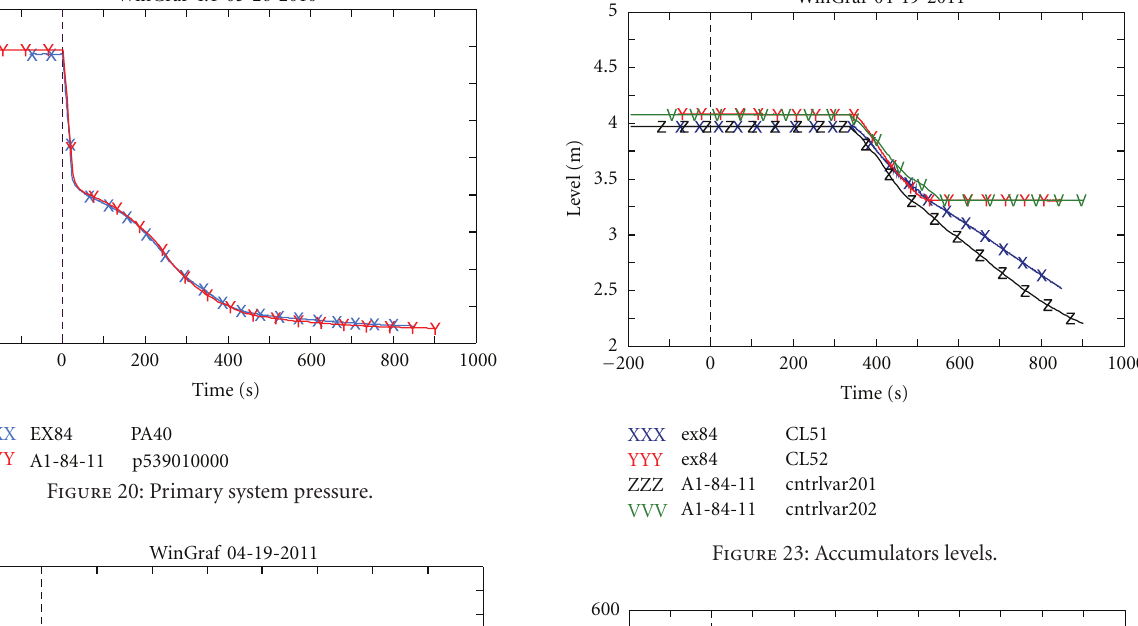
Figure 23: Accumulators levels.